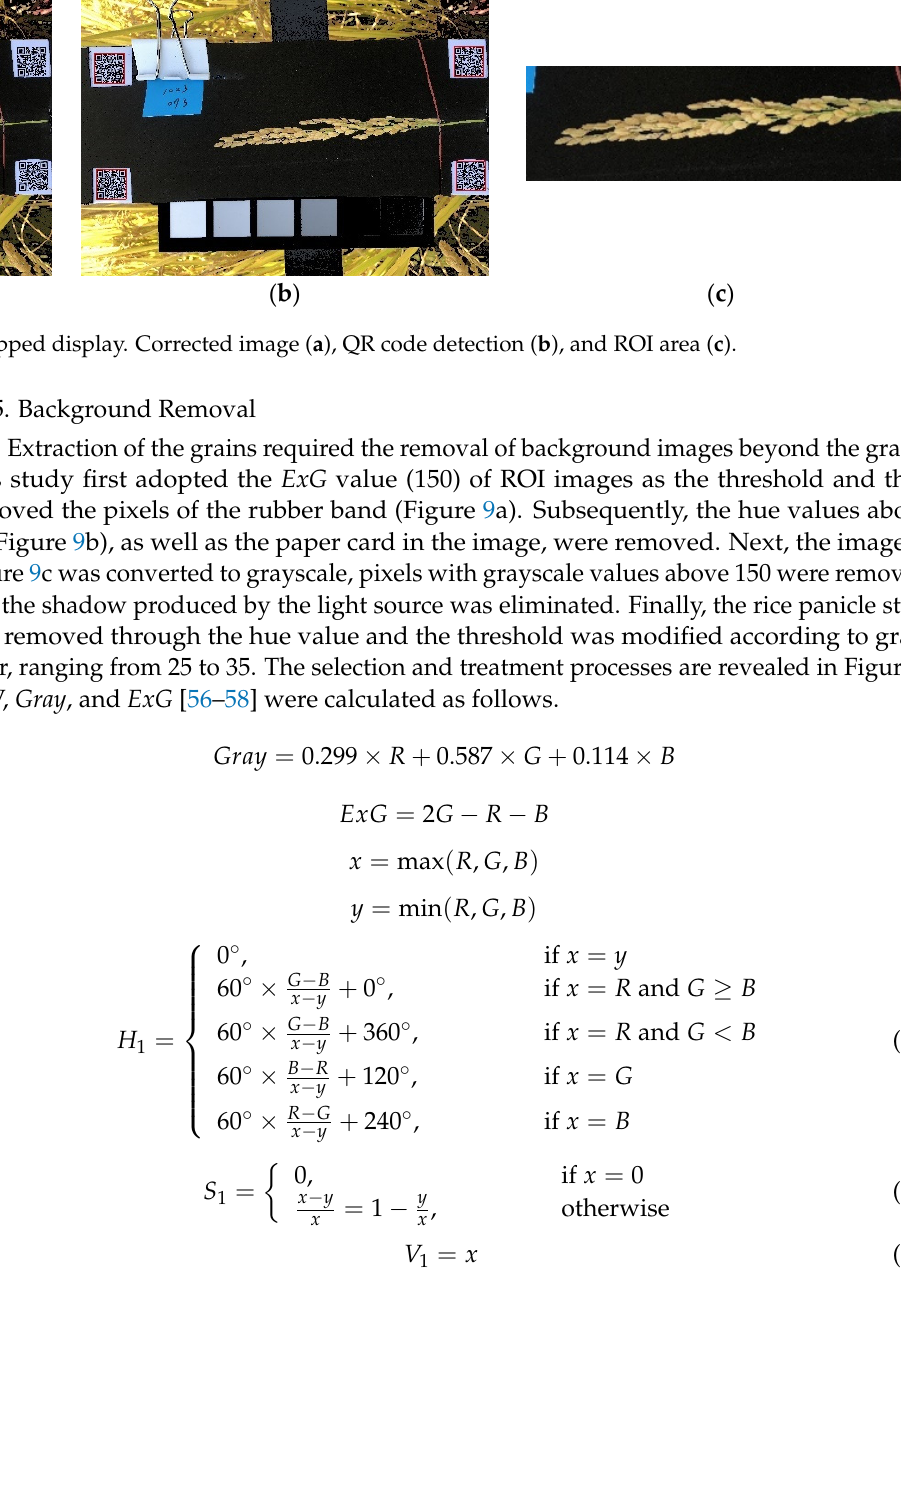
Figure 7. Image color calibration including contrast correction ( a ), gamma correction ( b ), and halation removal ( c ).